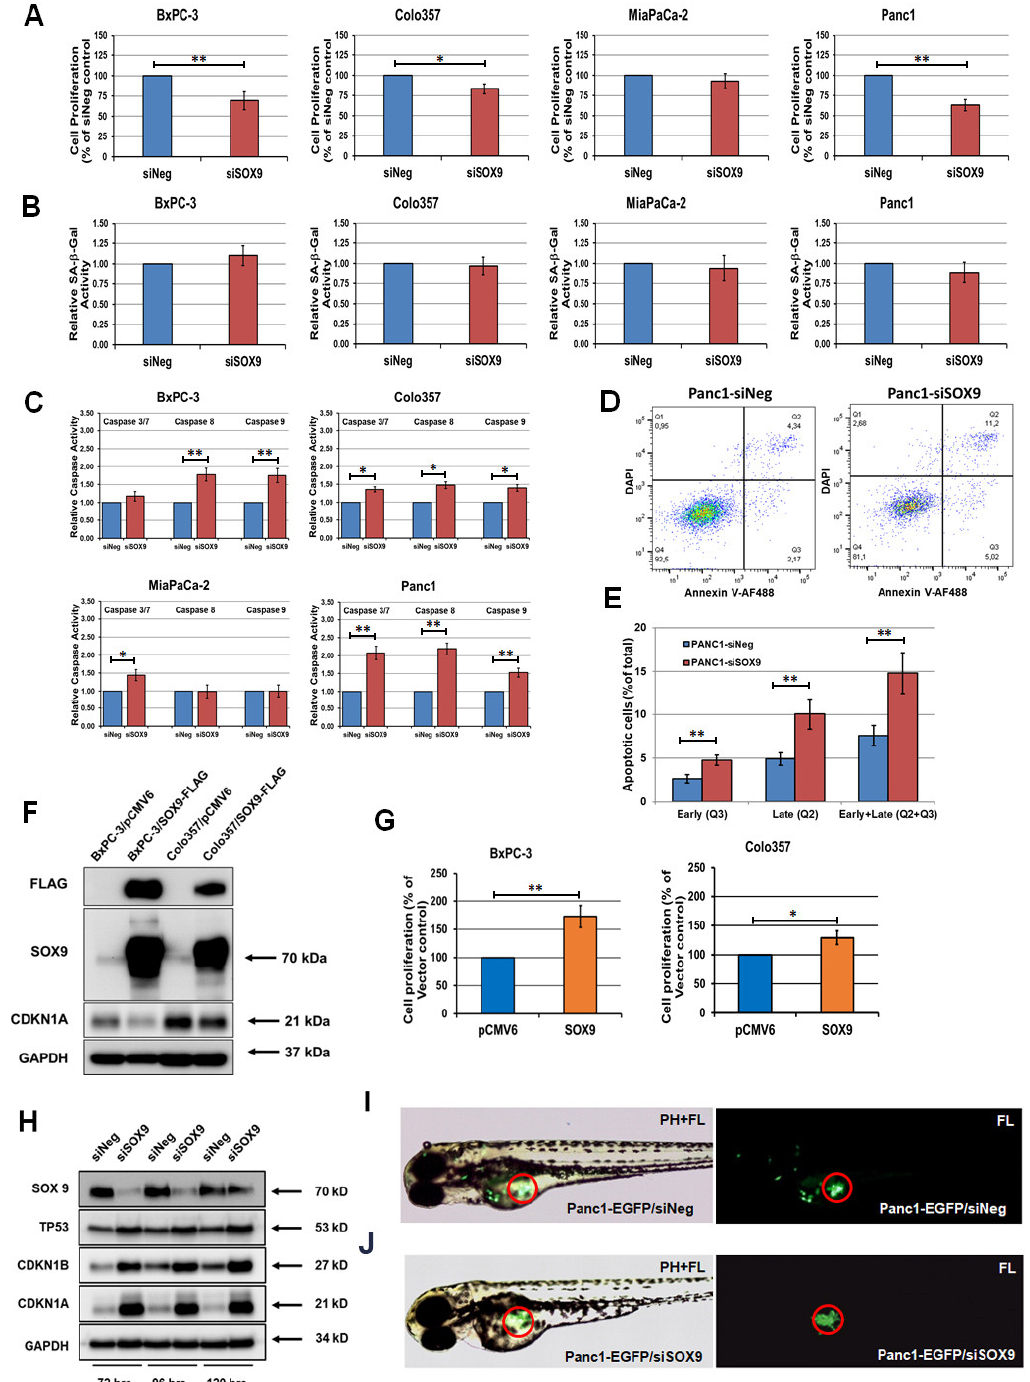
Figure 4. Effect of SOX9 expression on cell proliferation, cellular senescence, apoptosis, and cell migration. ( A ) Effect of SOX9 downregulation on the cell proliferation of BxPC-3, Colo357, MiaPaCa-2, and Panc1. Pancreatic cancer cells seeded in 6-well plates were transfected with siSOX9 and control siNeg. After 72 h, the cell number was measured by counting cells using the TC20 automated cell counter. Data were expressed as the percentage from control cell growth. Data are means ± SEM from three technical replicates and representative of at least three experiments. * p ≤ 0.05; ** p ≤ 0.01 compared with siNeg control. ( B ) Effect of SOX9 downregulation on the senescence-associated β - galactosidase (SA- β -Gal) activity of BxPC-3, Colo357, MiaPaCa-2, and Panc1 cells. SA- β -Gal activity data were expressed relative to SA- β -Gal activity levels in siNeg and siSOX9 transfected